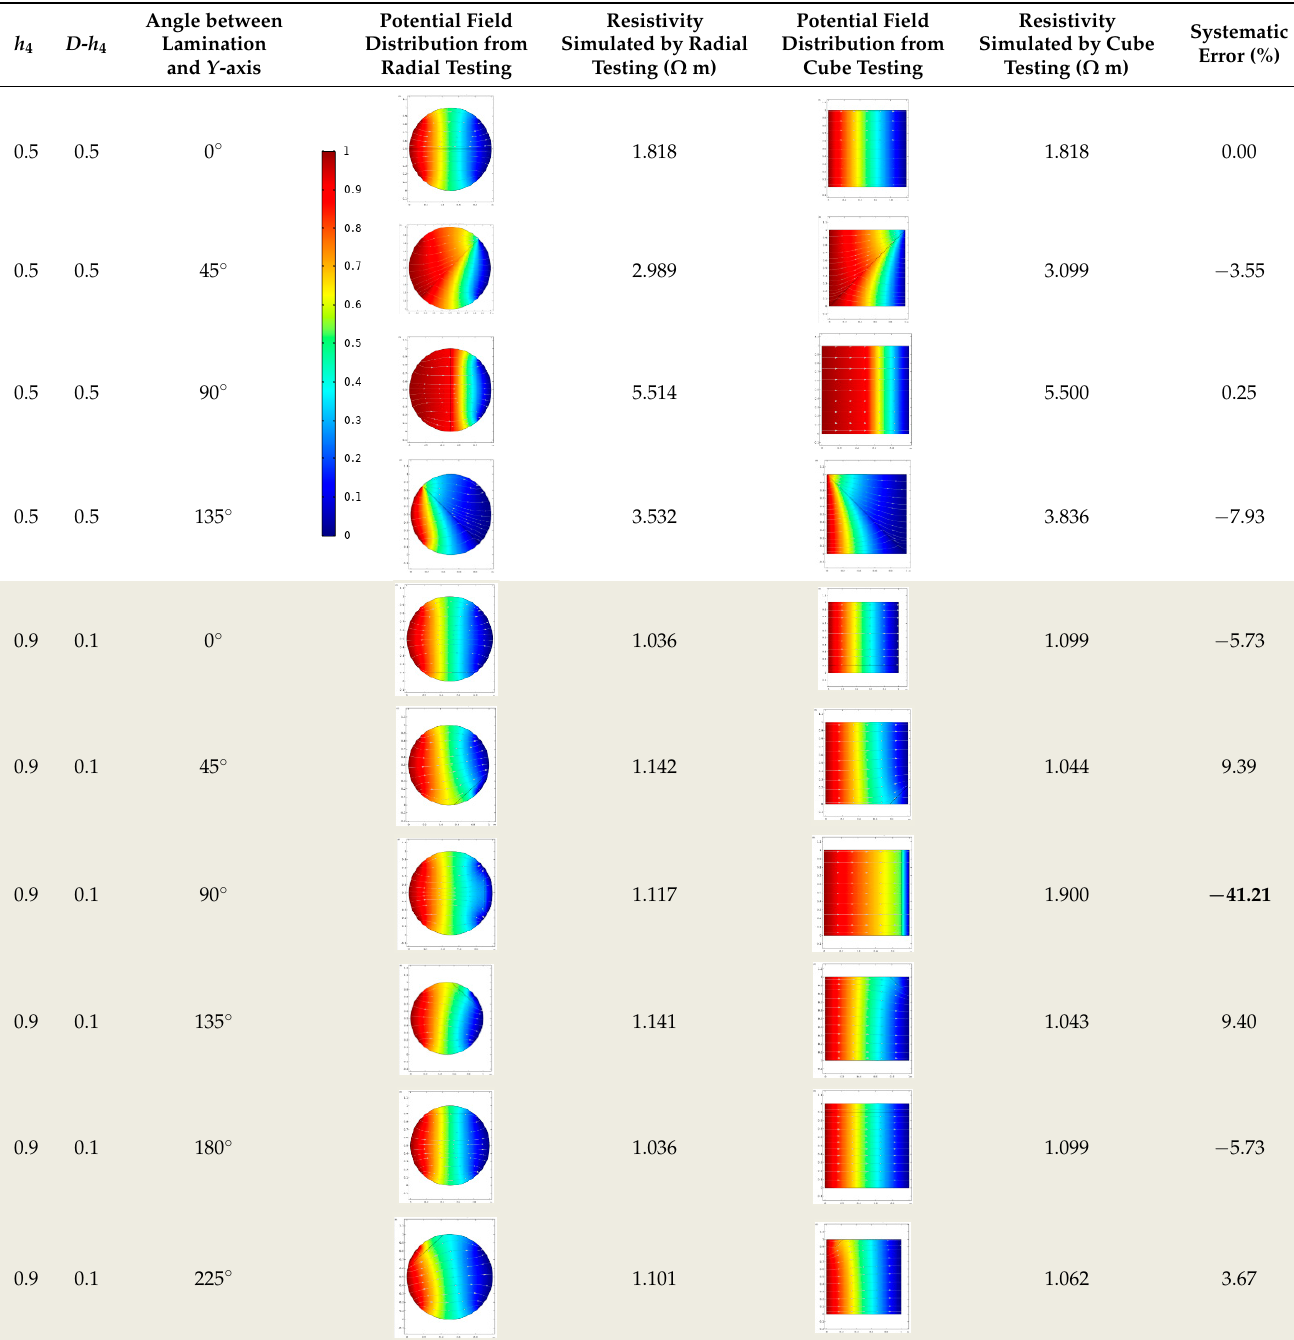
Table 3. Transitional Case 1: numerical simulation results of different material thicknesses.